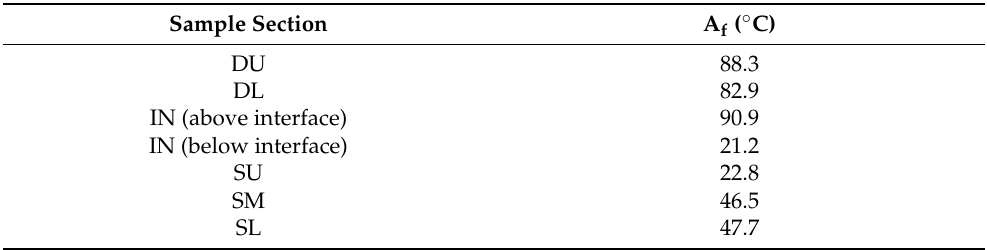
Table 1. Summary of the A f value of all sections within the bi-metallic SMA structure and the corresponding Z